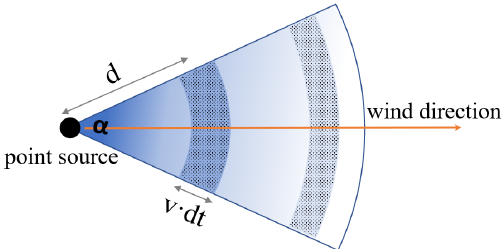
Figure A1. Sketch of the simple cone plume model used to explain the CH 4 emission estimation method. The CH 4 at the point source is distributed along the wind direction (wind speed: v ) in the cone-shaped area with an opening angle of α . The point source emits the CH 4 at an emission rate of ε . We assumed the CH 4 molecules are evenly distributed in the dotted area A, and the distance from area A to the point source is d . Therefore, the emitted CH 4 in dt time period equals the amount of CH 4 in the area A. It yields the equation: